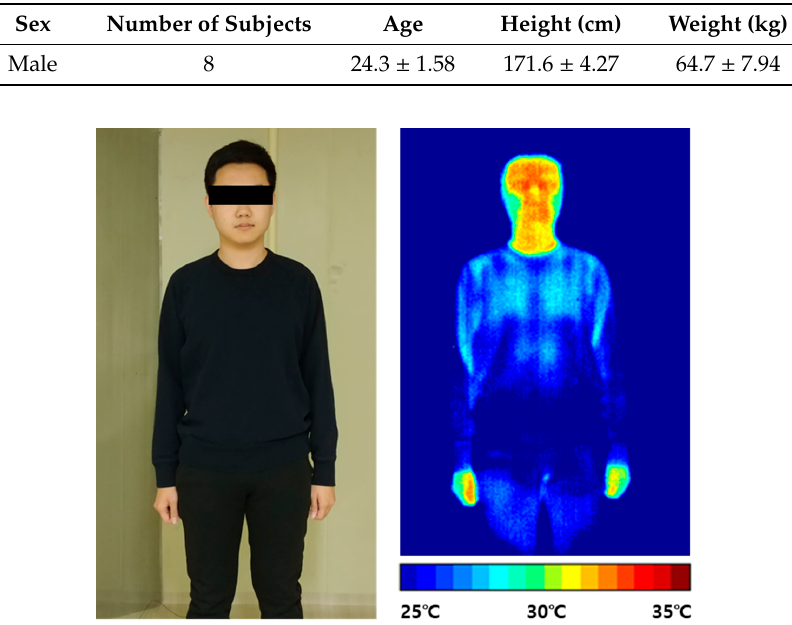
Figure 6. Skin and clothing temperatures measured using the IR camera.